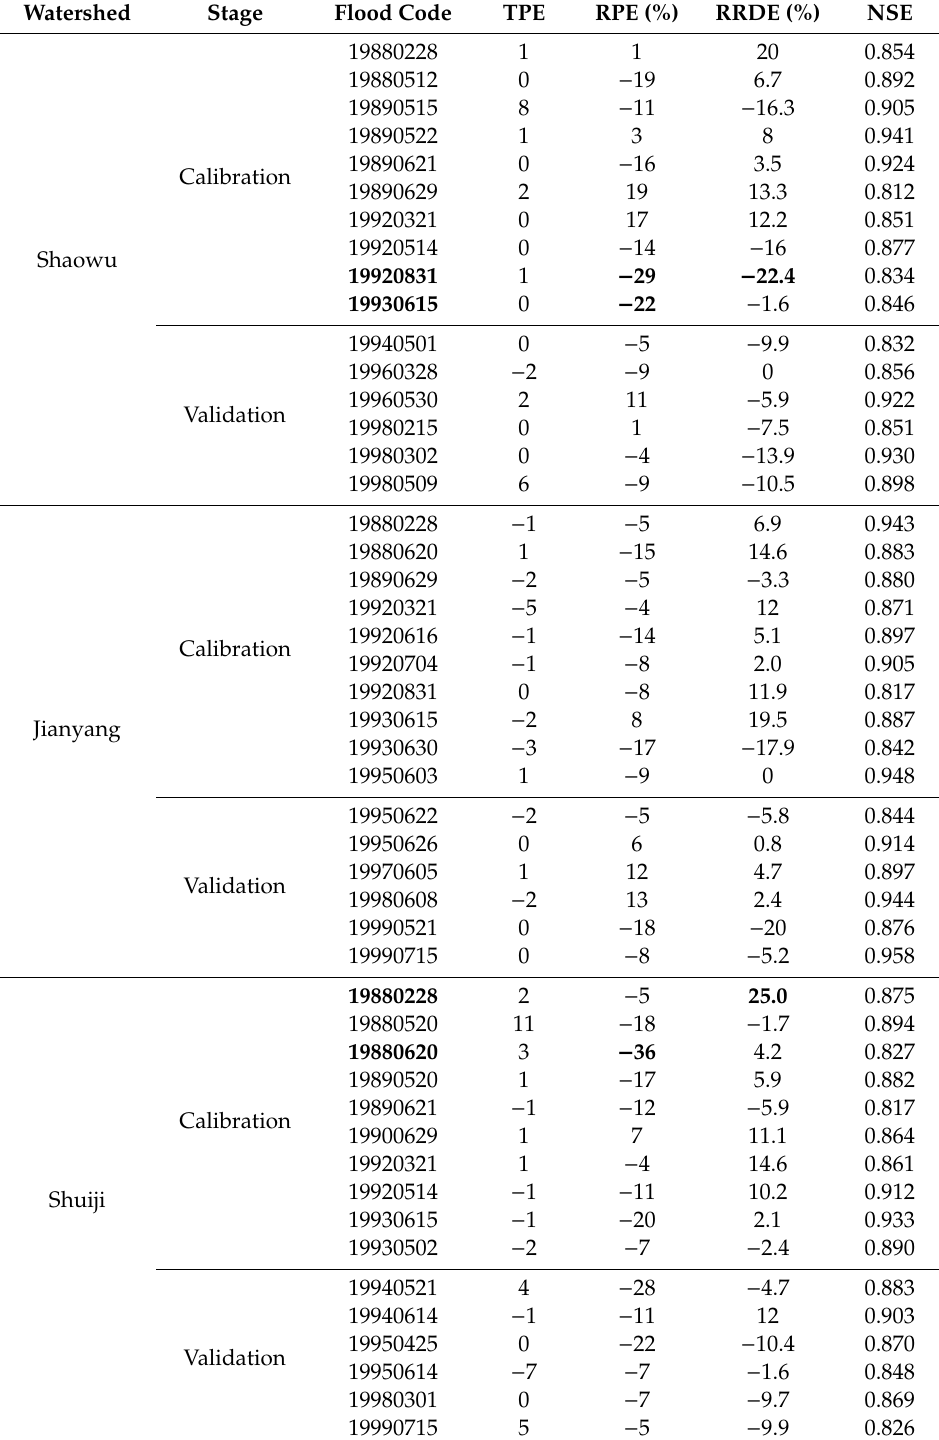
Table 4. Summarized values of evaluation criteria and performance of 10 calibrated and 6 validated flood events in Shaowu, Jianyang, and Shuiji